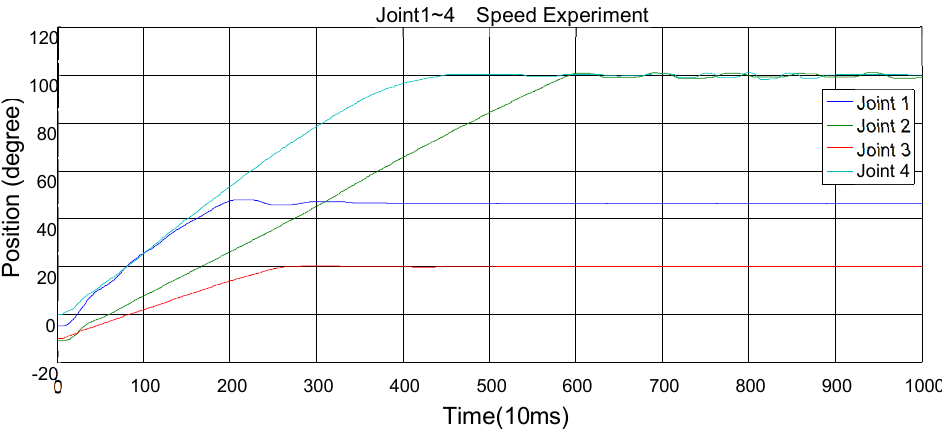
Figure 16. Four axes—curve of position rise versus time.